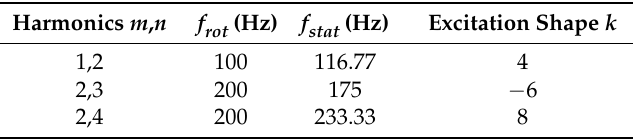
Table 2. Main excitation frequencies (rotating and stationary point of view) and corresponding excitation